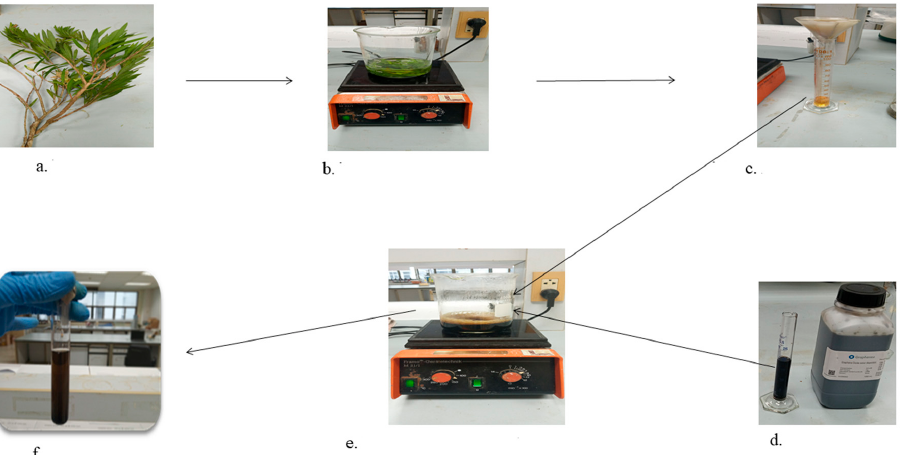
Figure 1. Reduced graphene oxide (r-GO) preparation: ( a ) plant leaf, ( b ) leaf extraction distilled water, ( c ) Leaf extract filtration, ( d ) graphene oxide (GO), ( e ) mixture of leaf extract and graphene oxide after vigorous stirring and ( f ) reduced graphene oxide.